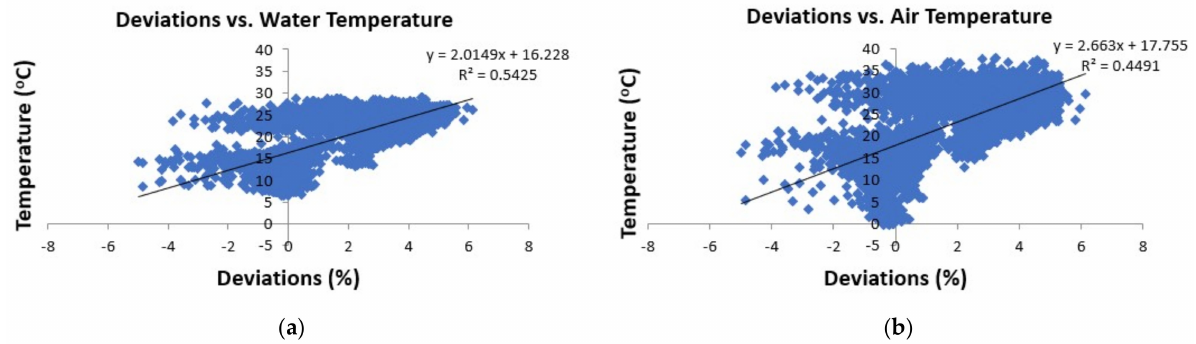
Figure 5. Percentage deviations of the pressure transducer water stages from the ultrasonic stages at Pikrodafni stream vs. ( a ) water temperature and ( b ) air